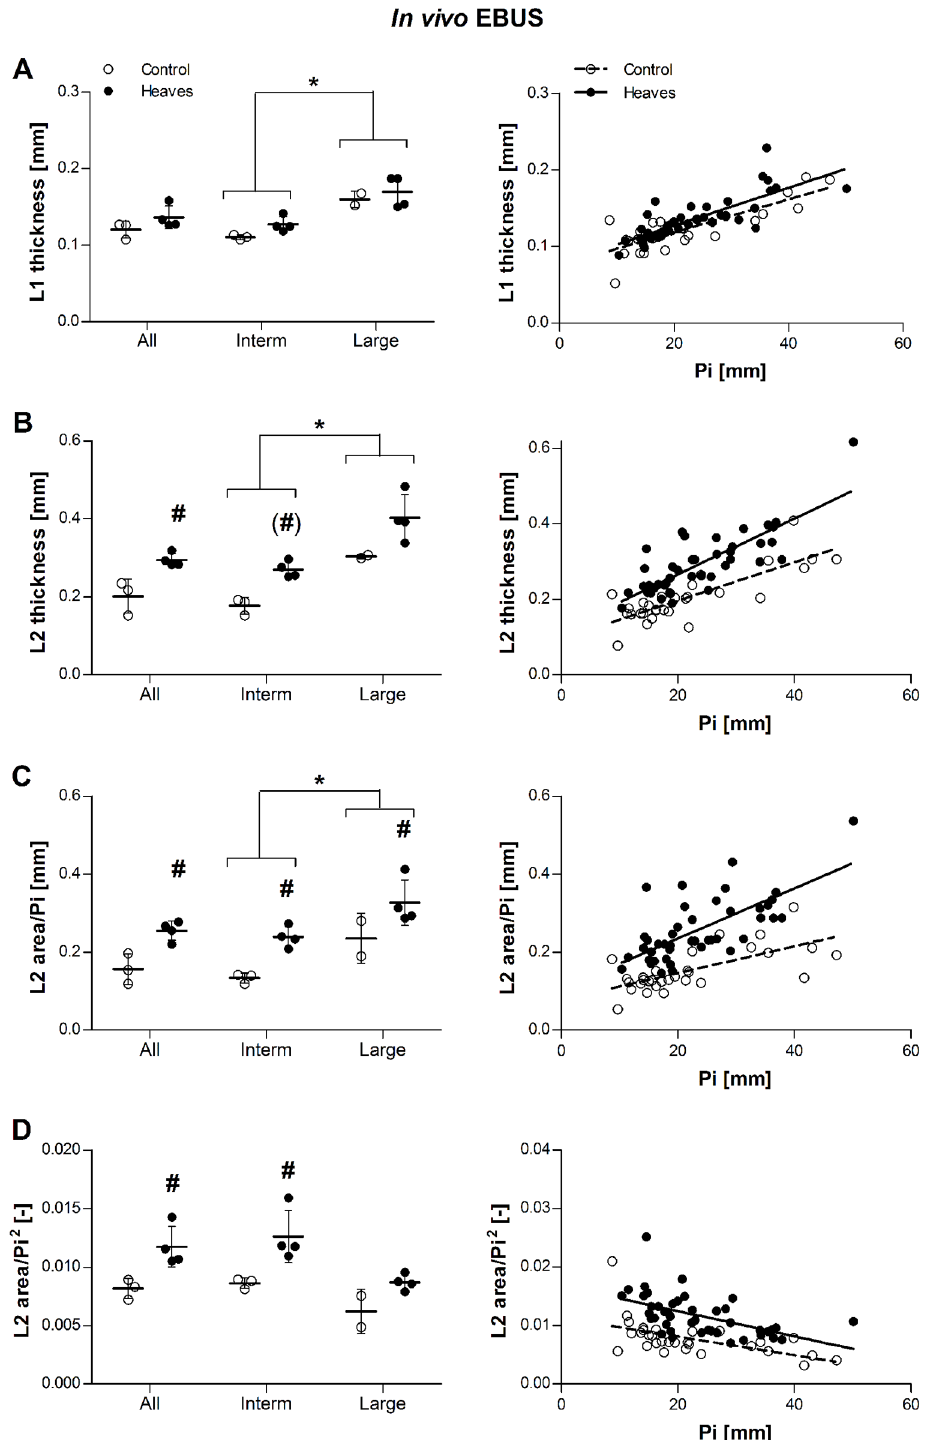
Fig 6. Effect of group and airway size on L1 thickness (A), L2 thickness (B), ratio L2 area/Pi (C), and ratio L2 area/Pi2 (D) in in vivo EBUS. Raw data (before statistical corrections) are presented as mean per animal in the graphs on the left, and as mean per airway the graphs on the right. L1 and was similar in horses with heaves and controls across all bronchi (p = 0.27). Contrarily, L2 thickness, L2 area/Pi and L2 area/Pi 2 ratios were greater in horses with heaves than controls across all bronchi (p = 0.03, p = 0.005 and p =